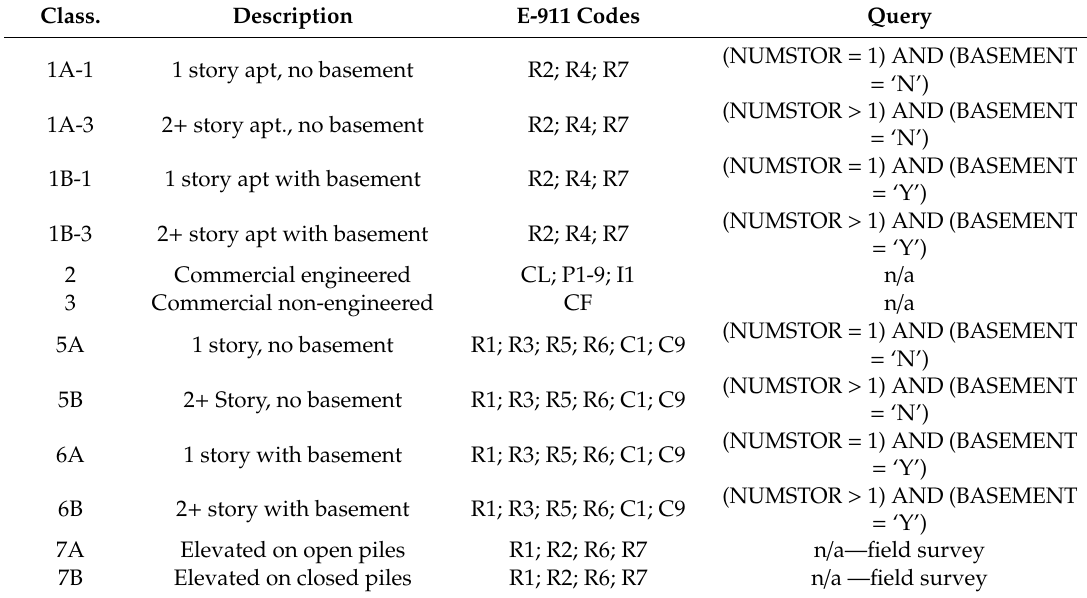
Table 2. NACCS building types as applied to the CERI structure database. A listing of E-911 use categories can be found here: https: // www.edc.uri.edu / projects / stormtools /